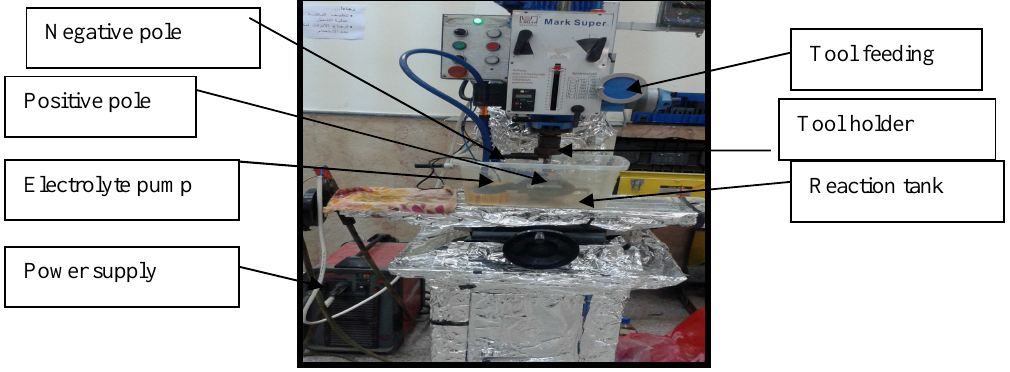
Fig. 2. Electrochemical